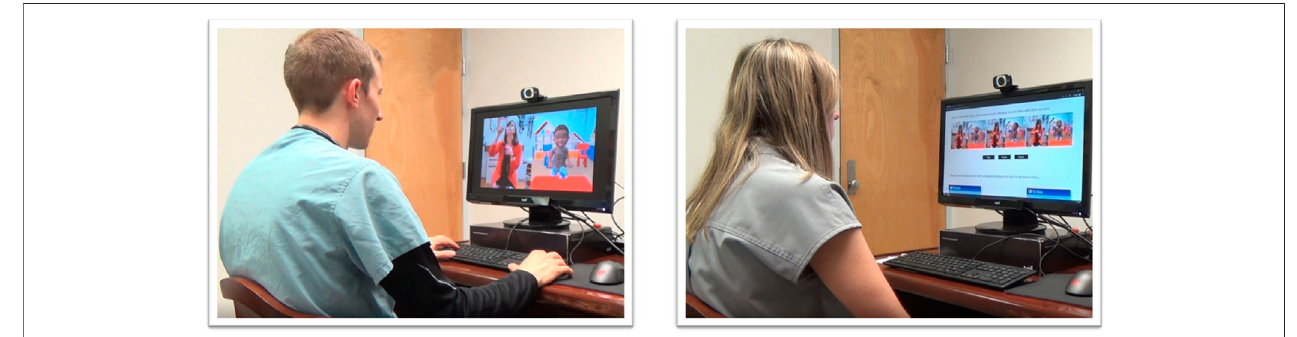
FIGURE 2 | Trainees using the two interfaces: single-view interface (left) , spectrum-view interface (right) .